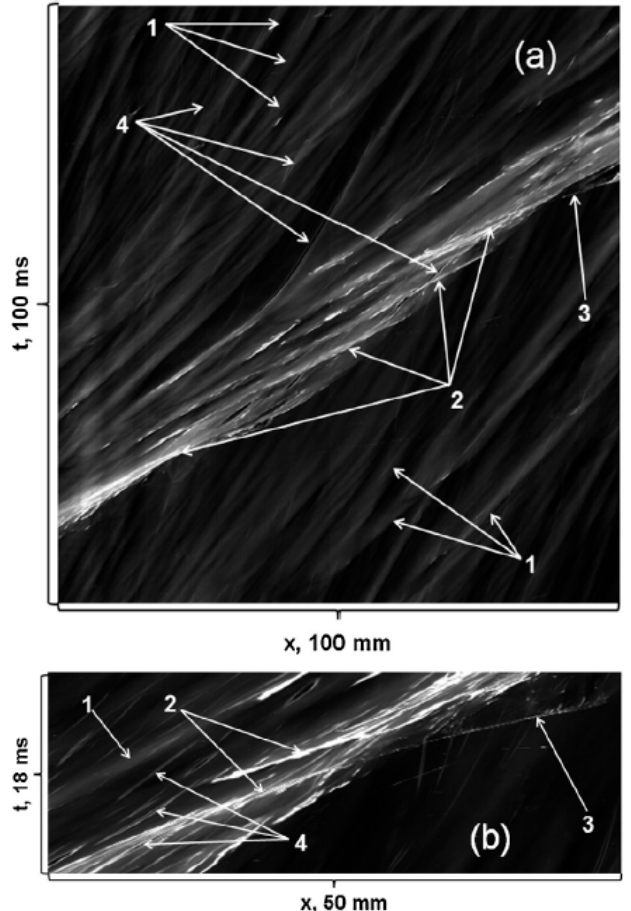
Figure 12. Spatiotemporal evolution of disturbance waves and ripples on gas-sheared liquid film in a horizontal rectangular duct [46]. Local brightness of the image corresponds to local instantaneous film thickness. A disturbance wave is seen as an inclined bright non-uniform stripe. The numbers denote: slow ripples (1), fast ripples (2), entrained droplet (3), entrapped bubbles (4). ( a ) A large fragment of h(x,t) matrix showing a disturbance wave and its surroundings; ( b ) A smaller magnified fragment showing the structure of a disturbance wave.